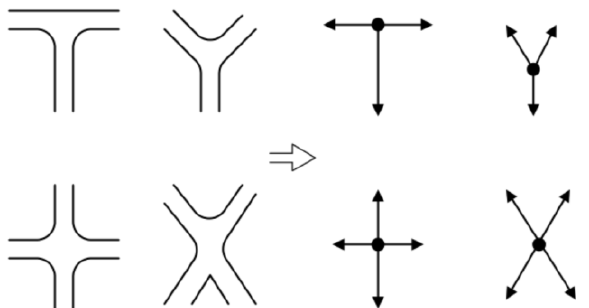
Figure 2. Road intersection models